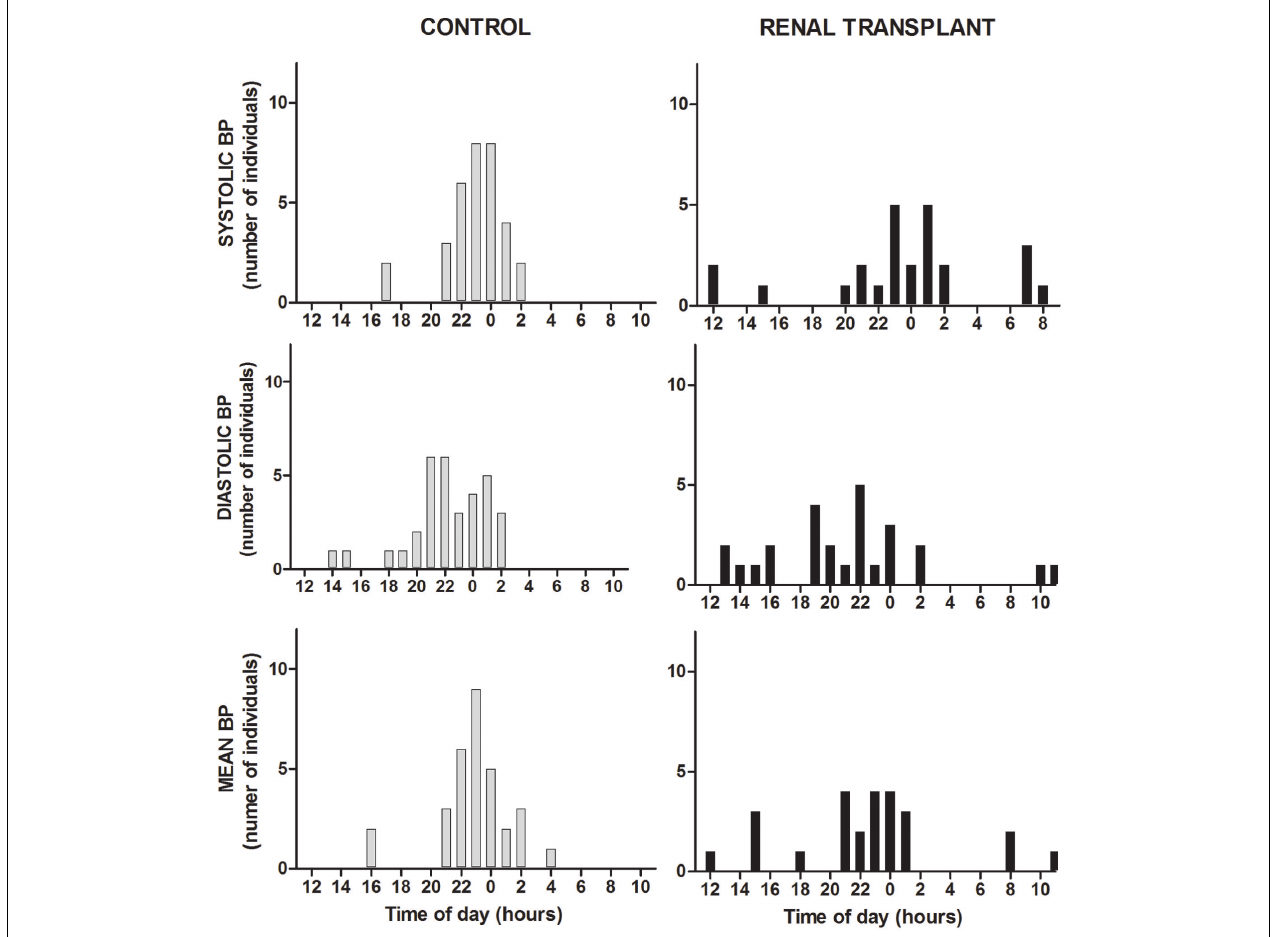
FIGURE 3 | Histograms showing the distribution of the times when transition from high to low blood pressure stages occur for SAP, DAP, and MAP in renal transplant recipients and